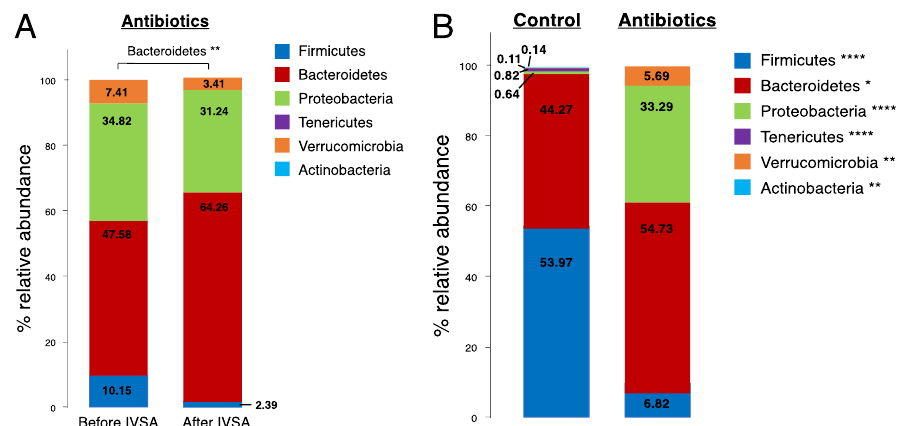
Figure 2. Alpha diversity at the phylum level in antibiotic-treated and control males. ( A ) Percent relative abundance of Firmicutes (dark blue), Bacteroidetes (red), Proteobacteria (green), Tenericutes (violet), Verrucomicrobia (orange), and Actinobacteria (light blue) in antibiotic-treated animals before and after fentanyl intravenous self-administration (IVSA). ** p < 0.01, n = 6–8/group. ( B ) Percent relative abundance of Firmicutes , Bacteroidetes , Proteobacteria , Tenericutes , Verrucomicrobia , and Actinobacteria in controls and antibiotic-treated animals. Data are collapsed by fecal collection timepoint. Asterisks (*) next to each phylum listed in the legend represent significant differences between controls and antibiotic treatment. **** p < 0.0001, ** p < 0.01, * p < 0.05, n = 9–14/group.